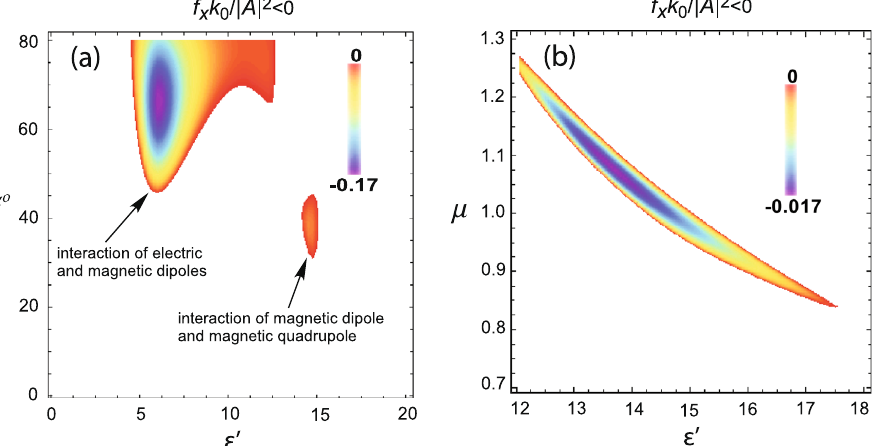
2 on ( a ) incident angle α and dielectric Figure 3. Dependence of the optical pulling force < f k A / 0 x 0 permittivity ε ′ ( μ = 1) and ( b ) magnetic permeability μ and permittivity ε ′ ( α = 35°). Incident wave is TE- polarized ( B = 0). Cylinder parameters are k 0 R = 1 and ε ″ =